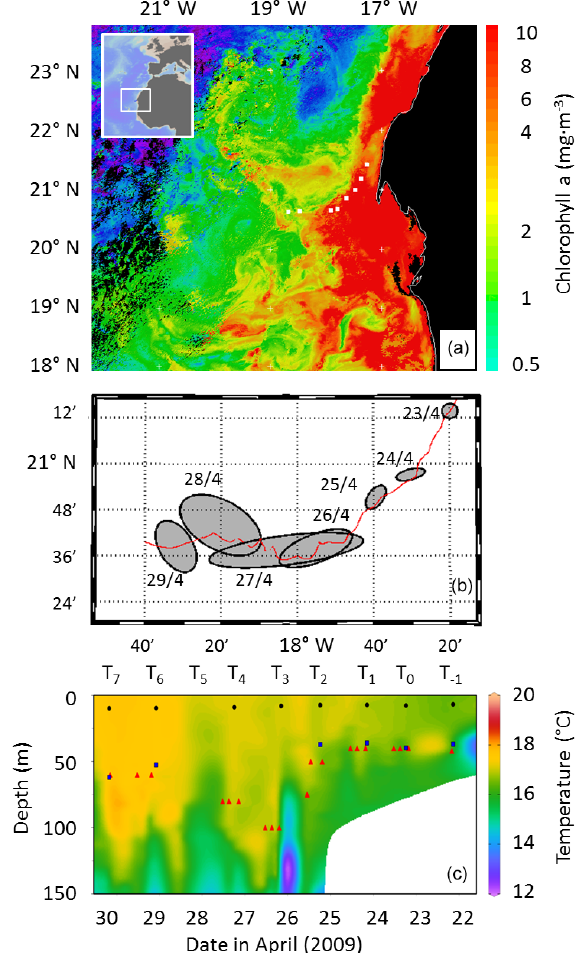
Figure 1. Panel (a) presents composite sea-surface chlorophyll a (20–30 April 2009) of the sampling area. The station locations are identified as white squares. Panel (b) presents the daily lateral SF 6 / 3 He distribution, defined as 40% of the peak concentration. The red line indicates the track of a central marker buoy used in combination with SF 6 / 3 He analysis. Panel (c) presents water col- umn temperature ( ◦ C) and includes sampling depths for 55% sPAR (black circles) and 1% sPAR (blue squares). The depth of the upper mixed layer is indicated (red triangles; Loucaides et al., 2012). Note the reversal of dates in (c) to aid comparisons between